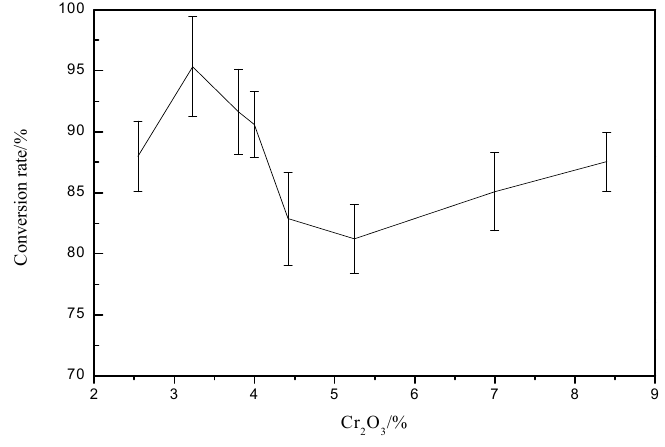
Figure 3. Effect of Cr 2 O 3 content on vanadium conversion rate.